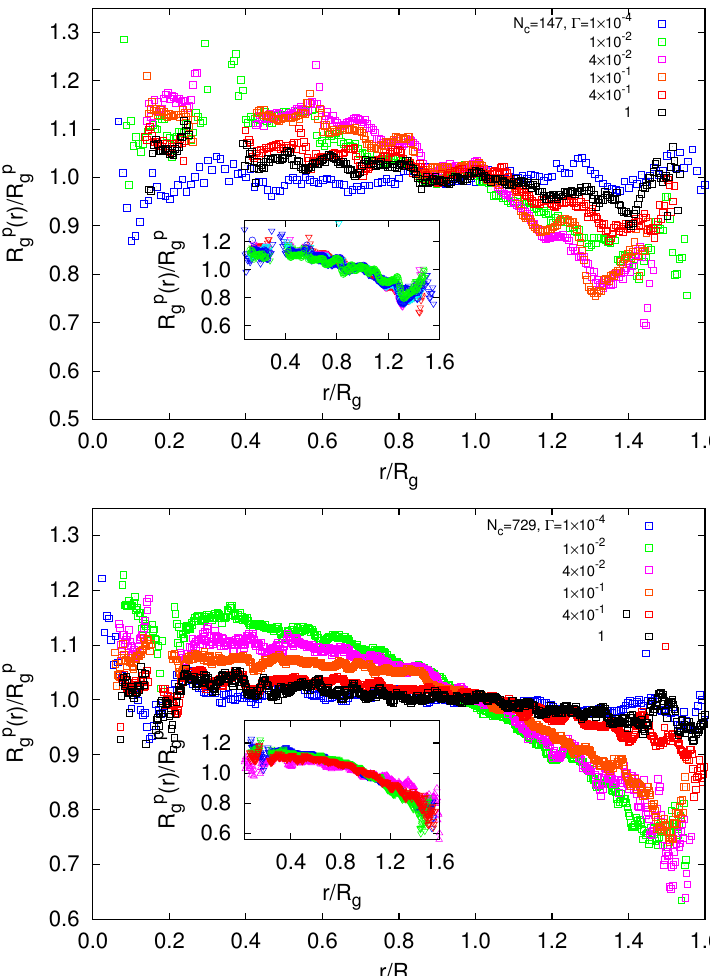
Figure 10. Dependence of the polymer radius of gyration on its radial center-of-mass position r for (top) N c = 147 and L / l = 300, and (bottom) for N c = 729 and L / l = 400. The insets show radii of gyration in the unscreened regime. The radii of gyration of the microgels are (top) R g / l = 17.9, 31.7, 40.5, 44.6, 45.7 and 44.0, and (bottom) R g / l = 33.9, 67.7, 77.1, 81.7, 80.7 and 40.2 with increasing Γ